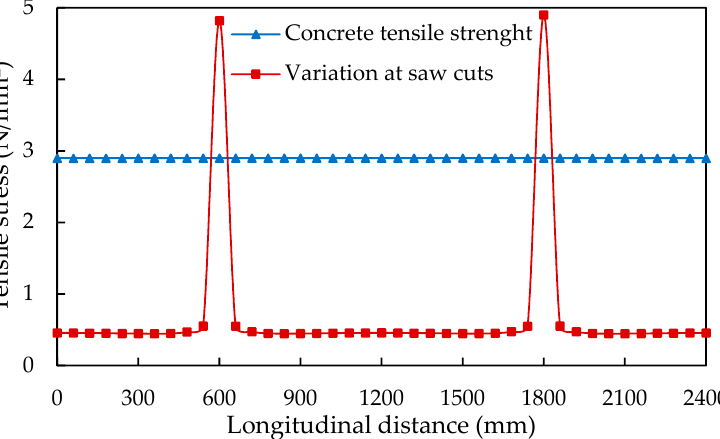
Figure 10. Development of maximum tensile stress against tensile strength over the saw-cut tips along the length of the pavement.